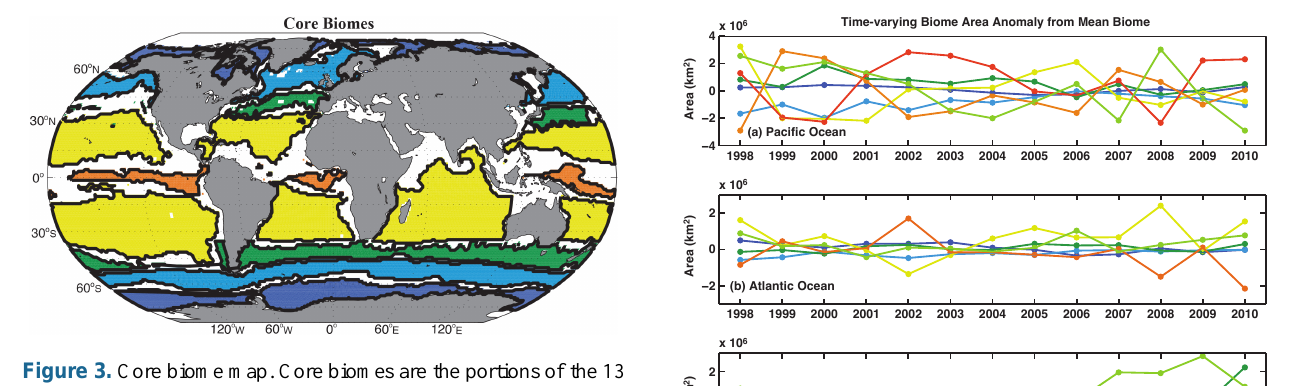
Figure 3. Core biome map. Core biomes are the portions of the 13 time-varying biomes that do not shift between one biome and an- other from year to year but remain as a single biome for all 13 years. Dark blue: ICE biome ; cyan: SPSS biome; green: STSS biome; yellow: STPS biome; orange: EQU biome . White indicates ocean areas that do not fit the criteria for any biome and also areas that shift biome assignments at least once between 1998 and 2010.